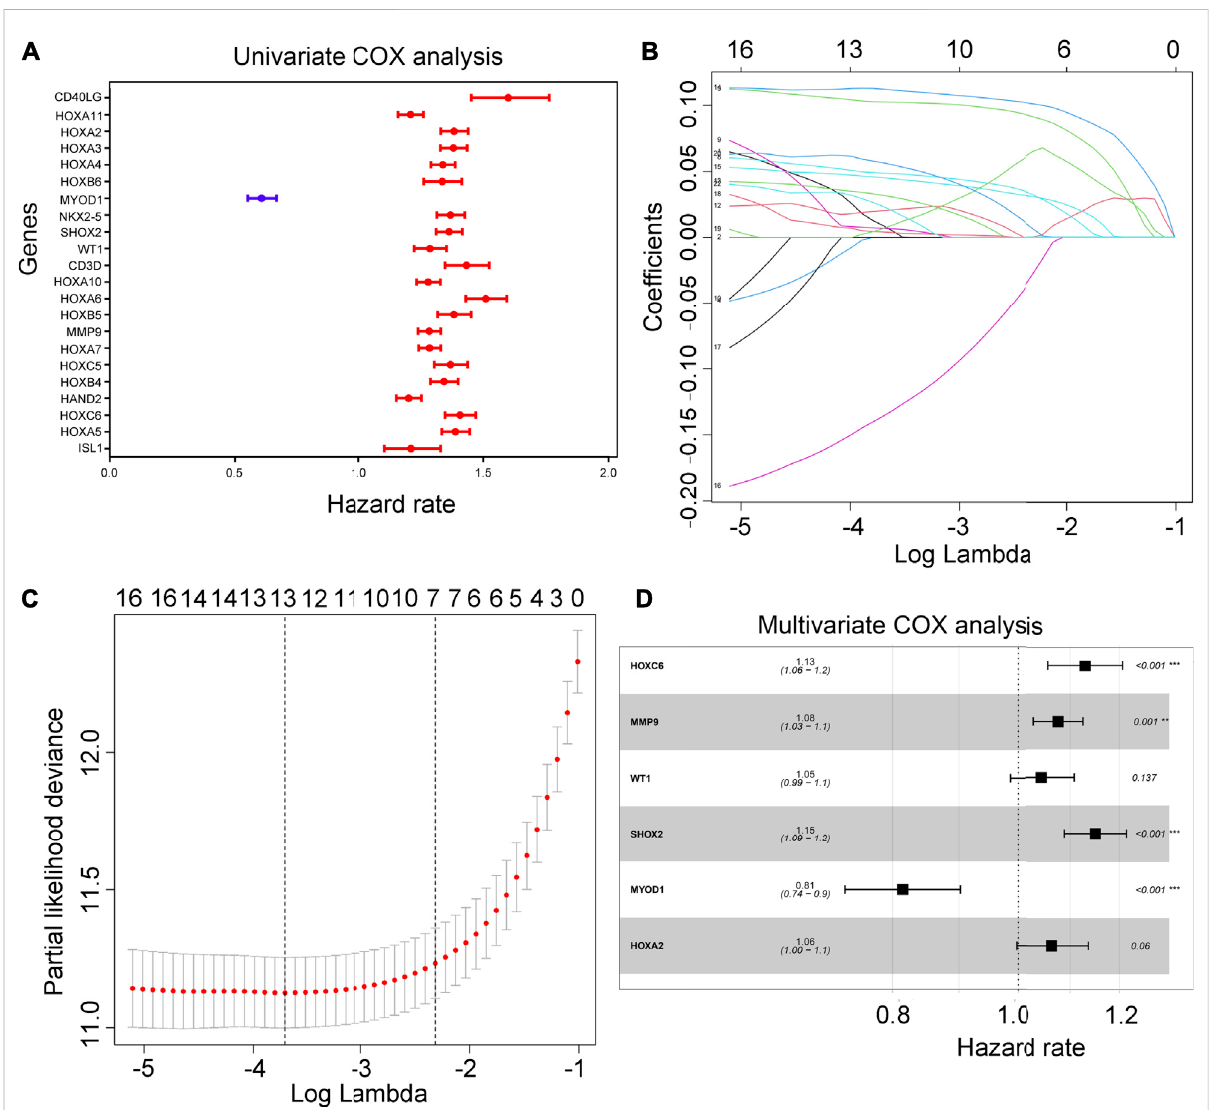
FIGURE 3 Constructionofriskmodel. (A) UnivariateCOXanalysisforthe22importanthypoxia-drivengenes.Blueindicatesgenesthatactaspredictorsof a favorable prognosis, while red indicates genes that act as predictors of an unfavorable prognosis. (B,C) LASSO penalized Cox regression analysis exhibiting the 13 important hypoxia-driven genes. (D) Multivariate COX regression analysis selected 6 important hypoxia-driven genes to construct the risk model. HOXC6, MMP9. SHOX2 and MYOD1 can act as an independent prognostic